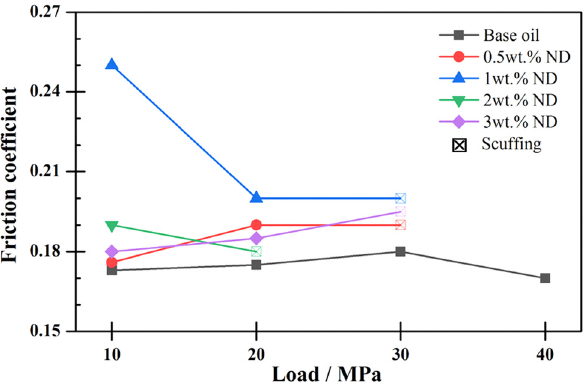
Figure 5: Variation of the friction coe ffi cient between the BP liner and the CrN - coated piston ring.